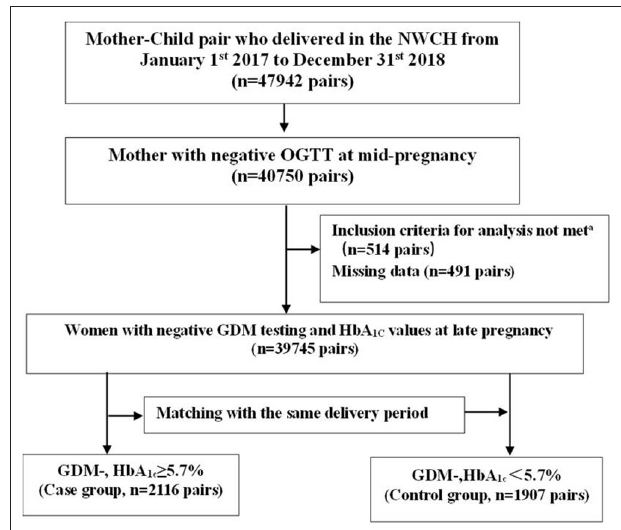
FIGURE 1 | Flow diagram outlining the selection of the study population. Inclusion criteria for analysis include singleton live birth, over 28 weeks gestational age, and absence of type 1 diabetes and type 2 diabetes. missing information for at least 1 of the following variables: pre-conception body mass index group, maternal HbA 1c at late pregnancy ( < 5.7% [39 mmol/mol] or ≥ 5.7%), or confounding variables. GDM-, gestational diabetes mellitus negative; HbA 1c , glycated